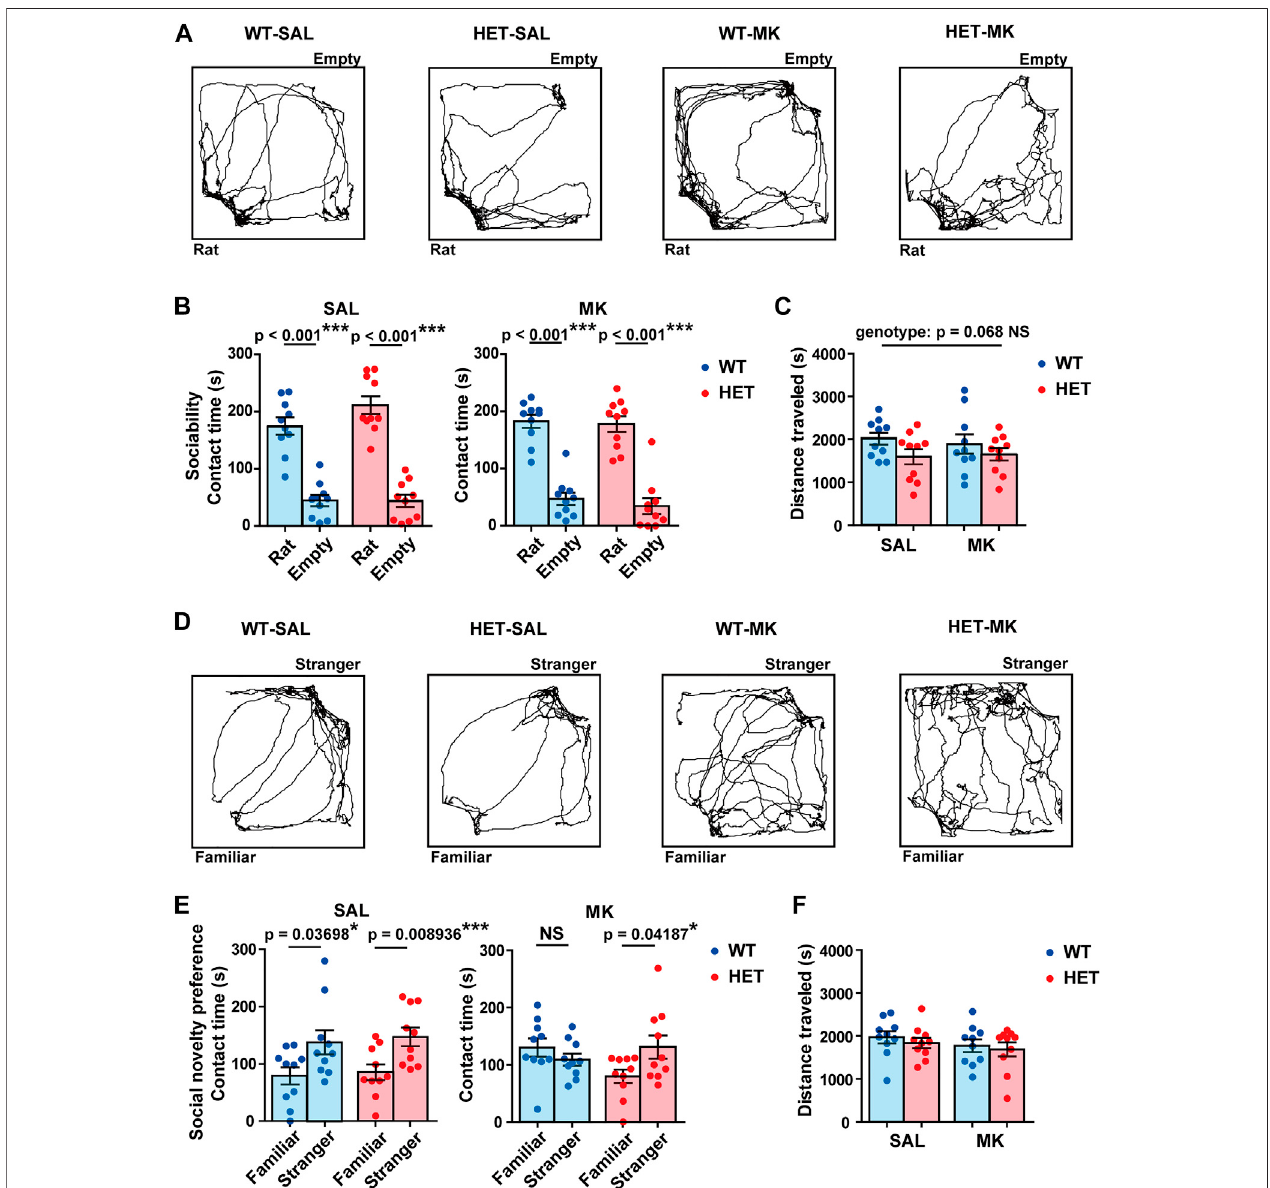
FIGURE 2 | MK-801 treatment affected the social novelty preference only in Gad1 WT rats. (A) Representative trajectories of rats in the sociability test. (B) All the groups preferred the rat-enclosed cage to the empty cage. (C) Although the distance traveled during the sociability test was not signi fi cantly different between the groups, asubthreshold effect ofgenotype wasfound ( p (cid:2) 0.068). (D) Representativetrajectories ofratsinthe socialnovelty preferencetest. (E) SAL-treatedratsofboth genotypes spent a longer timein contact with a stranger rat than they did with a familiar rat. MK-801 treatment diminished this trend in WT rats but not in HET rats. (F) Thedistancetraveledduringthesocialnovelty preferencetestwassimilar betweenthefourgroups. Theresultsarepresentedasaverage ± SEM.Datawereanalyzed using a t -test (B,C) or two-way ANOVA (C,F) . If a signi fi cant interaction of gene × drug was observed, a post hoc simple main effect test was performed. WT: wild-type, HET: Gad1 +/ − , SAL: saline, MK: MK-801. * p < 0.05, ** p < 0.01, *** p < 0.01; NS, not signi fi